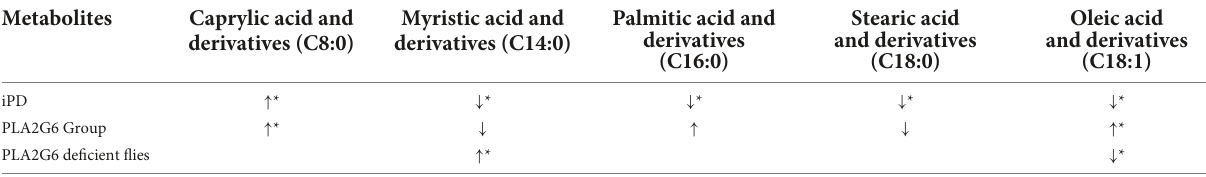
TABLE 4 Changes in fatty acid metabolism in the serum of individuals with iPD (from the references), PLA2G6 Group (this study), and in the homogenate of PLA2G6 deficient flies (from the reference).